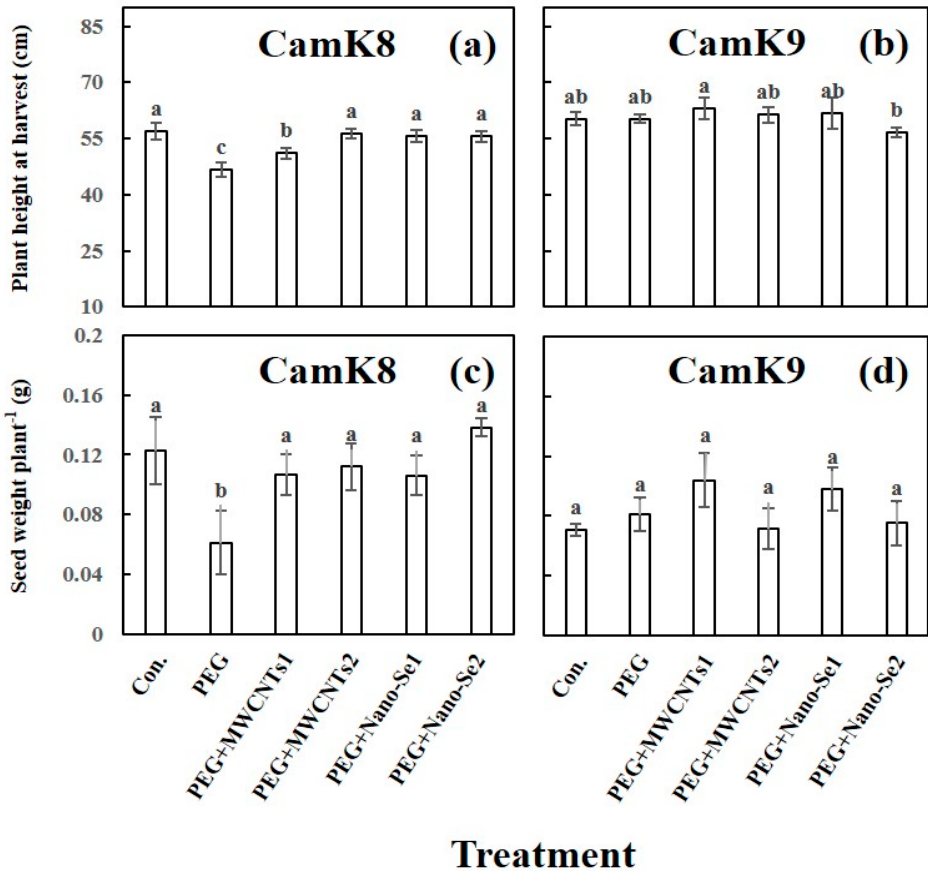
Figure 4. Effect of various treatments on plant height (cm) ( a , b ) and seed weight plant − 1 (g) ( c , d ) of CamK8 ( a , c ) and CamK9 ( b , d ) under PEG-induced WDS at harvest. Con.: un–treated control; PEG + MWCNTs 1 or 2: foliar application of MWCNTs with dose 1 (50 mg L − 1 ) or 2 (100 mg L − 1 ) following root application of PEG solution concentration (19.0 mM); PEG + nano-Se 1 or 2: foliar application of nano-Se with dose 1 (5 mg L − 1 ) or 2 (10 mg L − 1 ) following root application of PEG solution concentration (19.0 mM). Values are means ( n = 3) and bars denote the standard error of the mean. Different letters represent the significant different values determined by the Tukey post hoc test ( p ≤